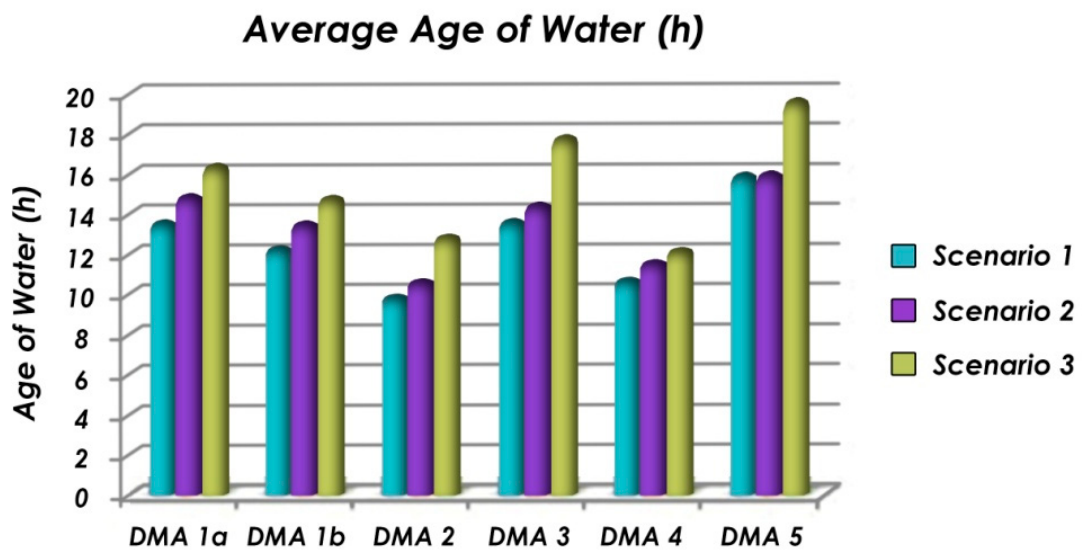
Figure 6. Average age of water in each DMA for the three scenarios studied.